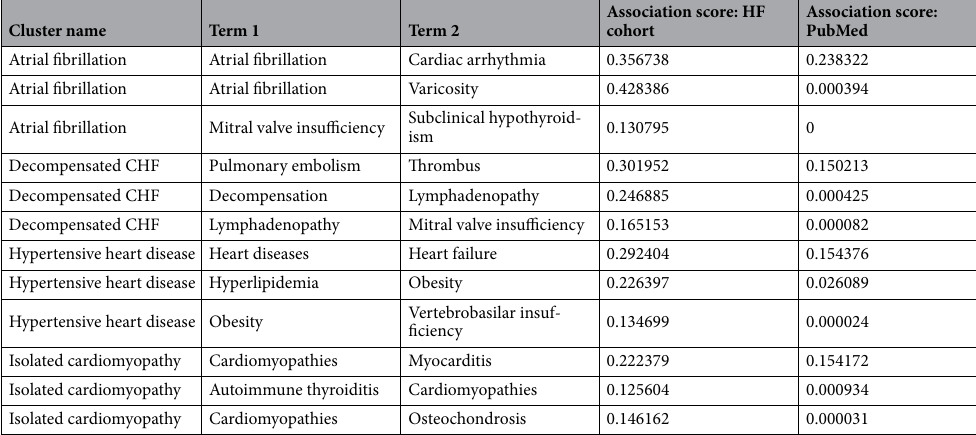
Table 3. Exemplary association scores between pairs of medical concepts that co-occur within cluster phenotypes from Table 2. Comparable association scores within the HF cohort and the scientific